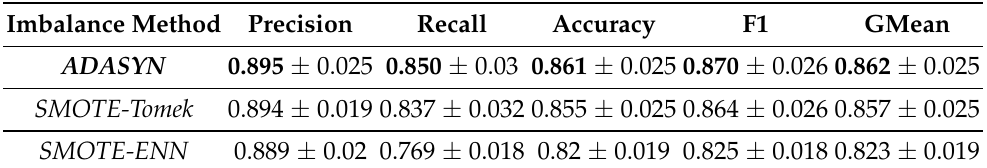
Table 4. Performance comparison of the the binary bot classifier, using ADASYN, SMOTE-Tomek and SMOTE-ENN imbalance methods. ADASYN provides better